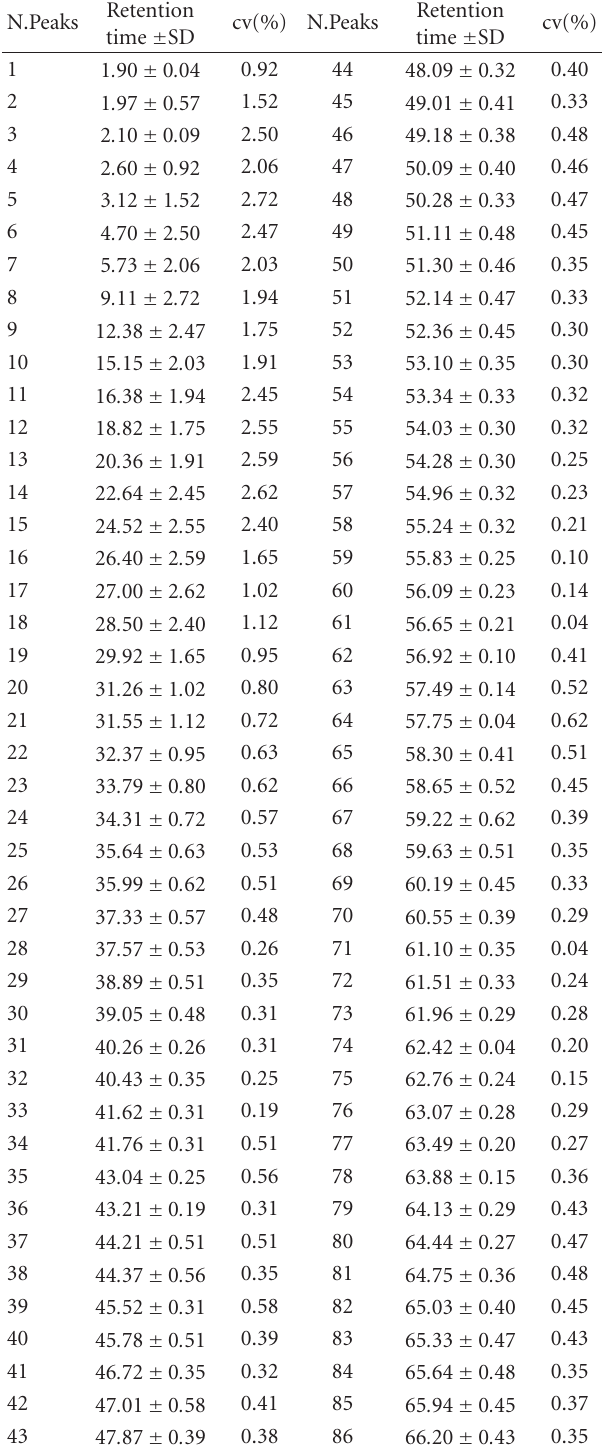
Table 3: Repeatability of retention time (sample Frutafit IQ).